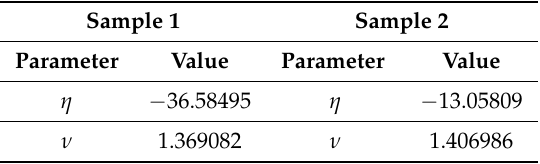
Table 3. Estimated parameters of O-U process for T